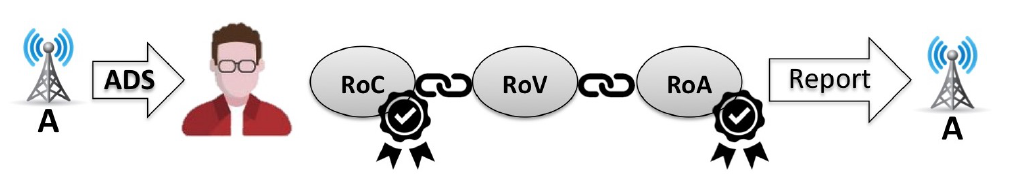
Figure 6. Behavioural verification by advert